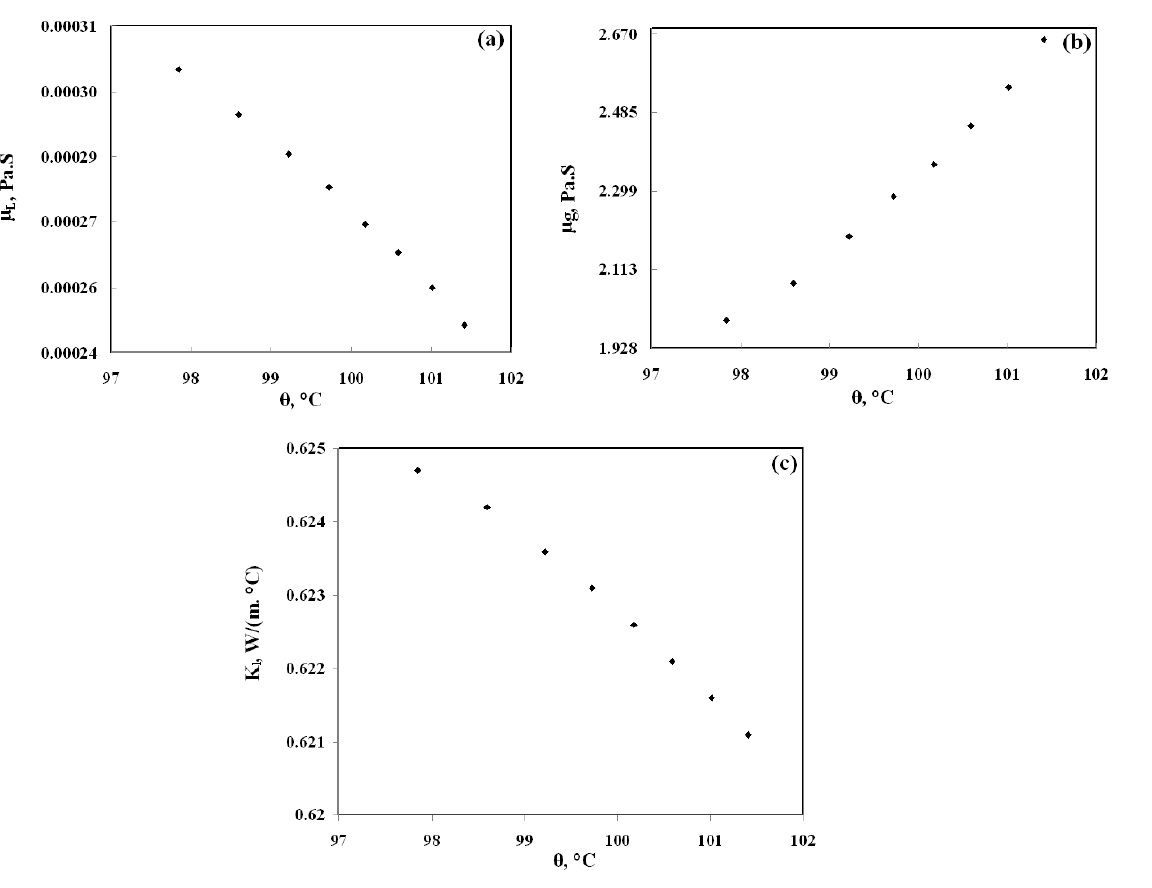
Figure 4: Changes in liquid and vapor viscosities, and thermal conductivity of two-component water-ethanol solution (3% by volume) at different